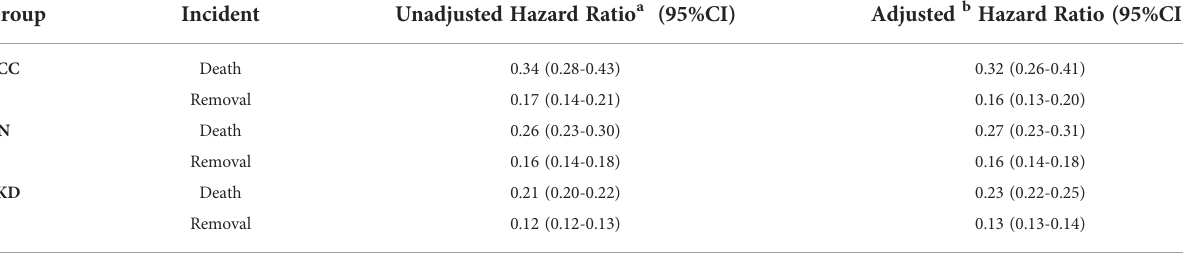
TABLE 6 Cox regression of RCC versus glomerulonephritis versus polycystic kidney disease for estimating survival bene fi t from transplantation. Group